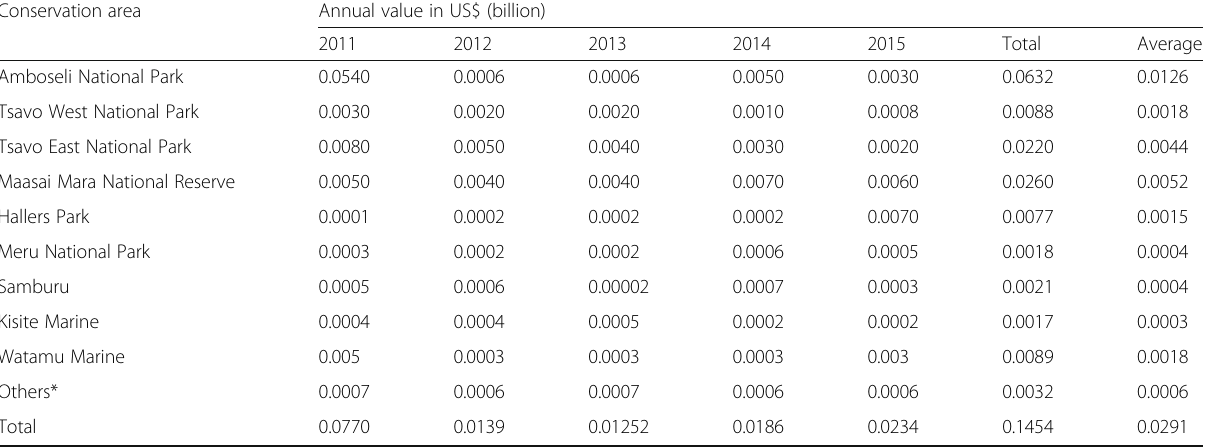
Table 7 Kenya pastoral parks and reserves revenue in US$ (billion); I US$ is equivalent to Kshs 100 Conservation